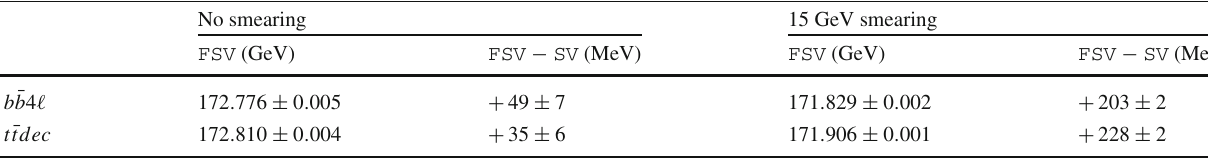
Table 13 m Wb peak position for m t =172.5 GeV for b ¯ b 4 (cid:4) and t ¯ tdec showered with Herwig7.1 using the FullShowerVeto ( FSV ) procedure. j The differences with ShowerVeto ( SV ), that represents our default, are also shown No smearing 15 GeV smearing